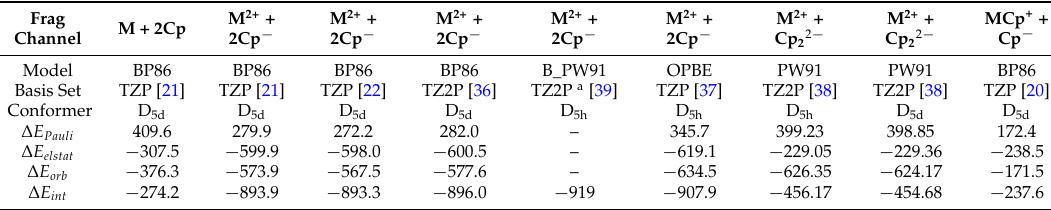
Table 1. Summary of previous EDA studies for ferrocene conformers in the literature (kcal ¨ mol ´ 1 )